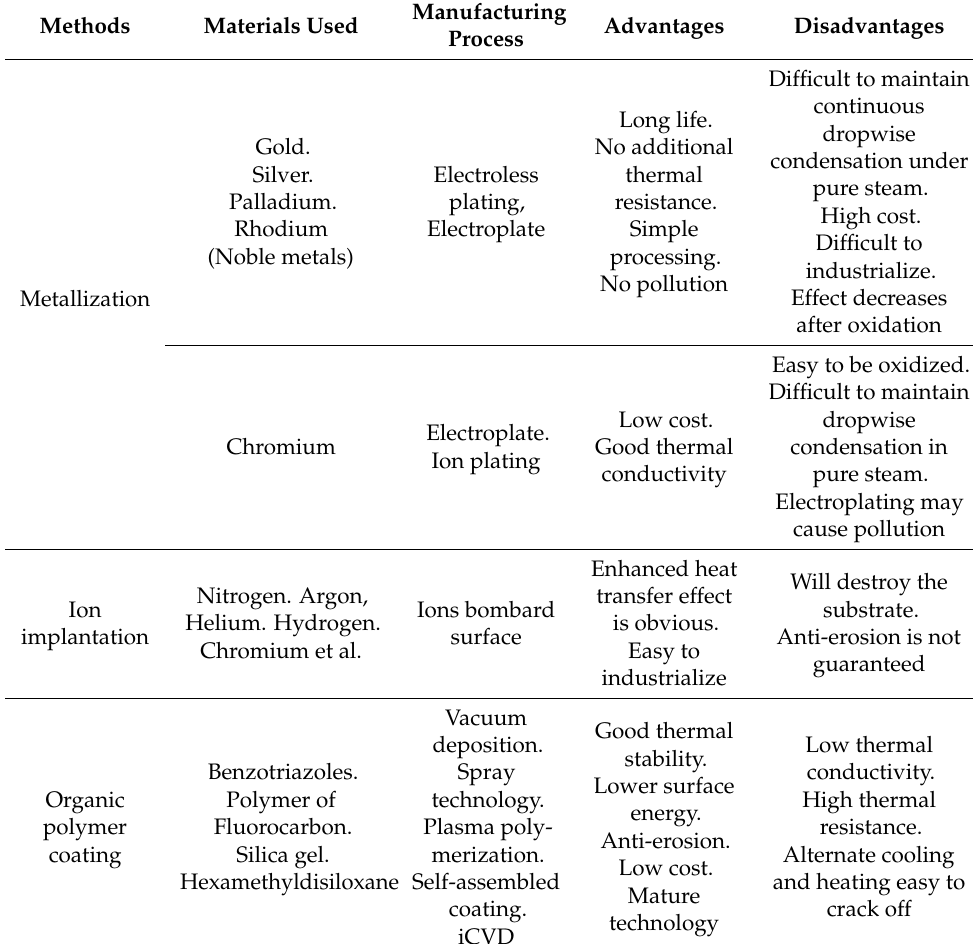
Table 1. Main methods for reducing surface free